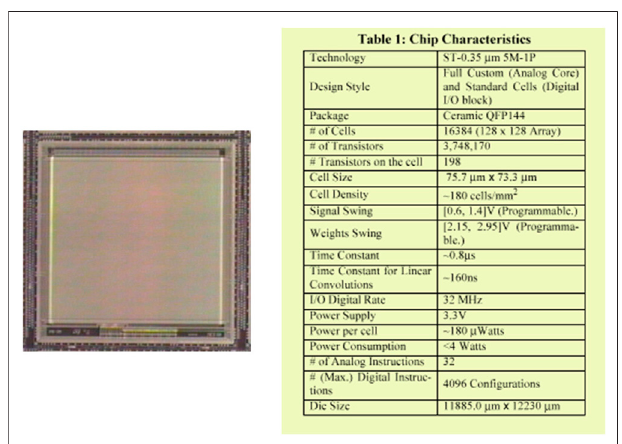
FIGURE 1 | Photograph and list of chip characteristics of the 128 × 128 CNN-UM chip developed during the FP4 DICTAM